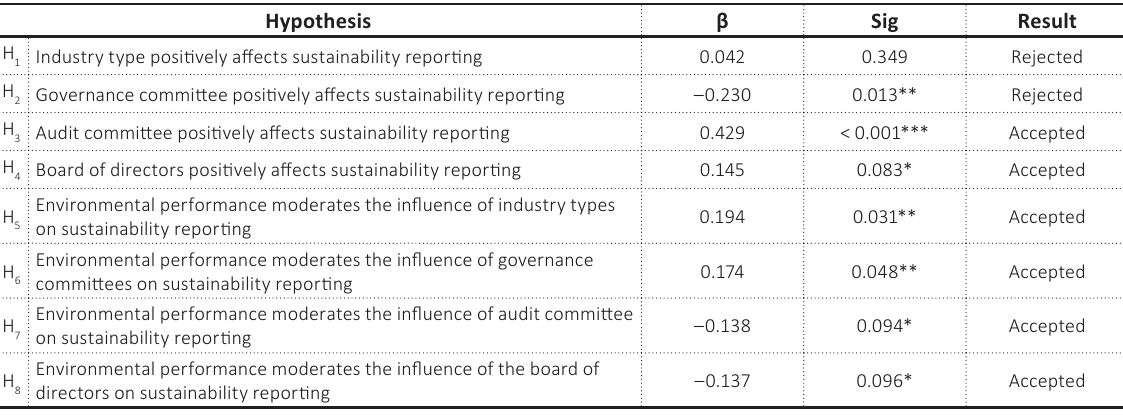
Table 3. Hypotheses